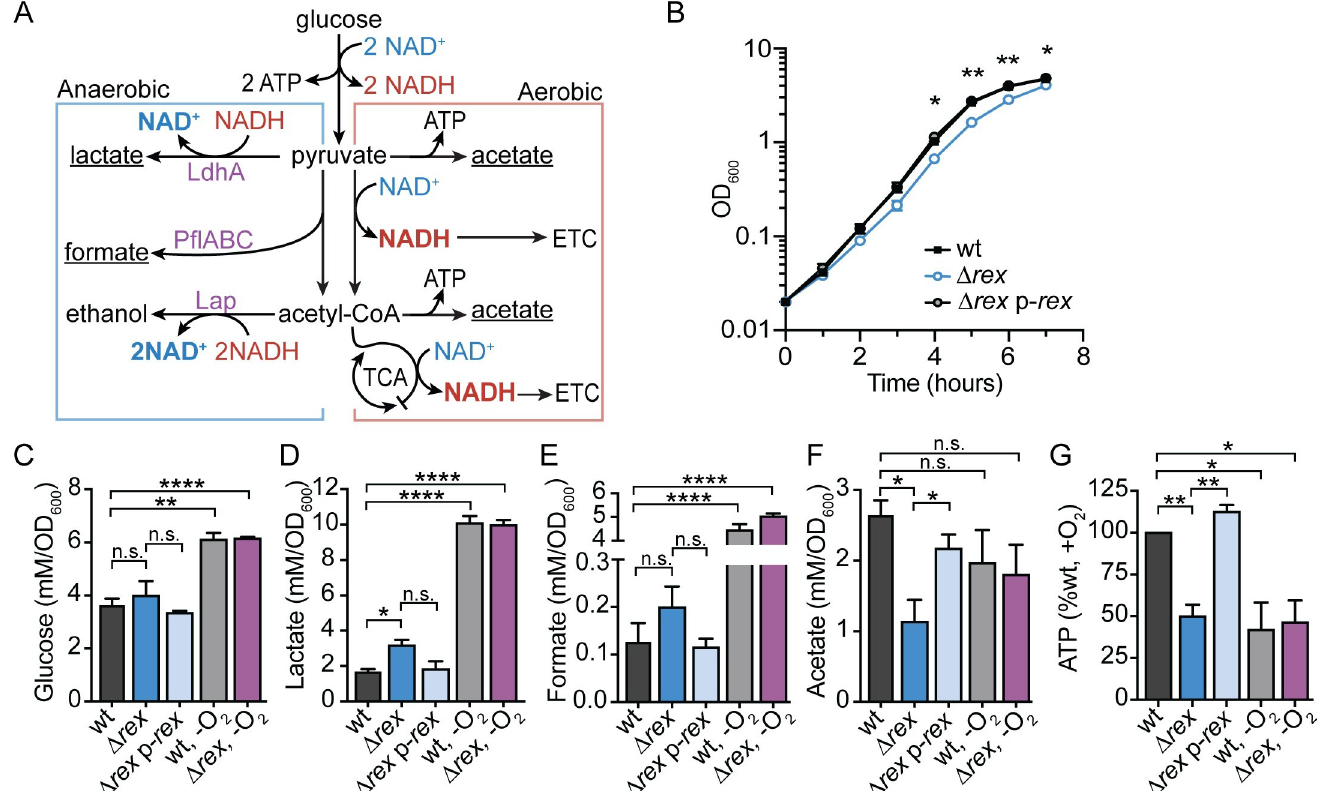
Fig 1. Fermentative metabolism is repressed by Rex during aerobic growth. A. Model of aerobic and anaerobic central metabolic pathways in L . monocytogenes . Enzymes encoded by genes repressed by Rex are denoted in purple text. Underlined metabolic end-products were those differentially produced by Δ rex compared to wt during aerobic growth. LdhA, lactate dehydrogenase; PflABC, pyruvate formate lyase; Lap, alcohol dehydrogenase; ATP, adenosine triphosphate; NAD(H), nicotinamide adenine dinucleotide; ETC, electron transport chain; TCA, tricarboxylic acid cycle. B. Aerobic growth of wt, Δ rex , and the complemented strain ( Δ rex p- rex ) measured by optical density (OD 600 ). C-F. Glucose and extracellular metabolites were quantified 4 hours post-inoculation in aerobic (black, blue, and light blue bars) and anaerobic (grey and purple bars) cultures. Concentrations of glucose (C), lactate (D), formate (E), and acetate (F) were determined and normalized to OD 600 . G. Relative intracellular ATP concentration was measured at 4 hours during aerobic (black, blue, and light blue bars) and anaerobic (grey and purple bars) growth. Data are the means and standard error of the mean (SEM) of three independent experiments in all panels with the exception of panel G. Here, anaerobic samples are the means and SEMs of two independent experiments. p values were calculated using a heteroscedastic Student’s t test. � p < 0.05; �� p < 0.01; ���� p < 0.0001; n.s. p > 0.05. In all panels, no significant difference was found between wt and Δ rex p- rex . In C-G, no significant difference was found between the wt and Δ rex strains grown in anaerobic